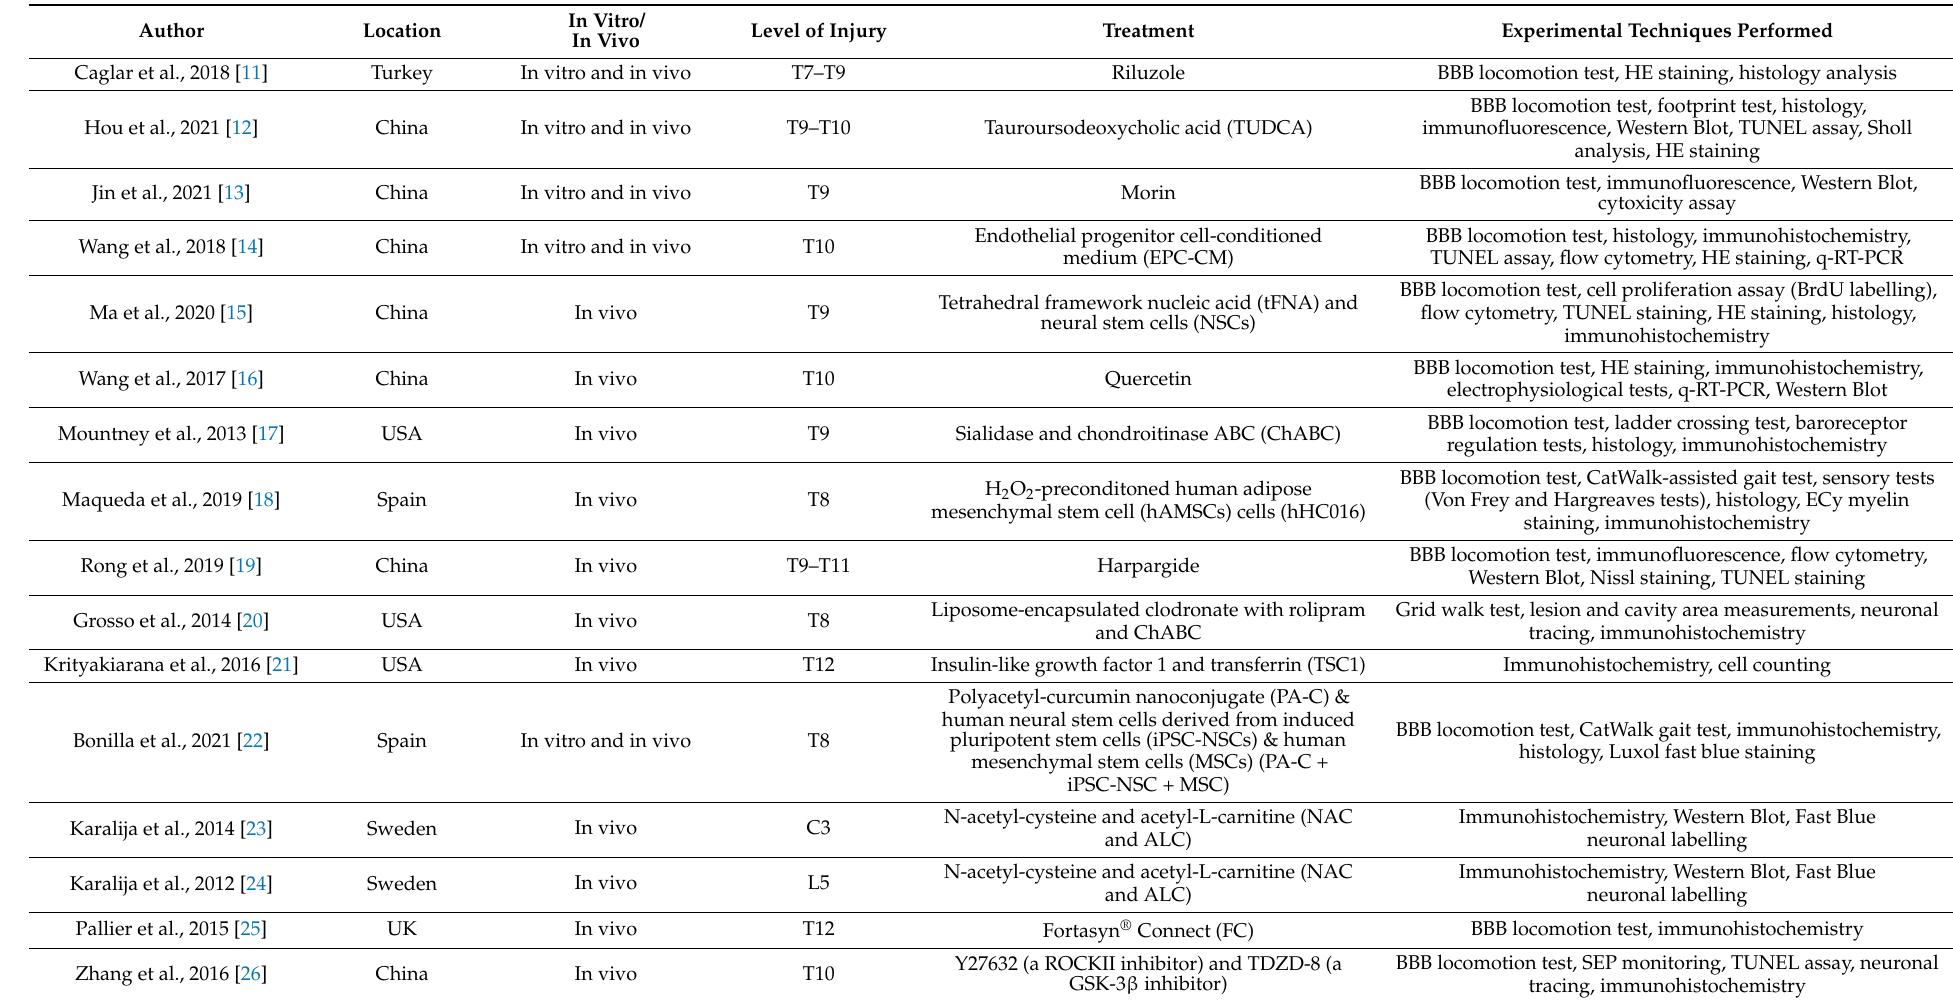
Table 1. Summary of the key characteristics of all 44 included